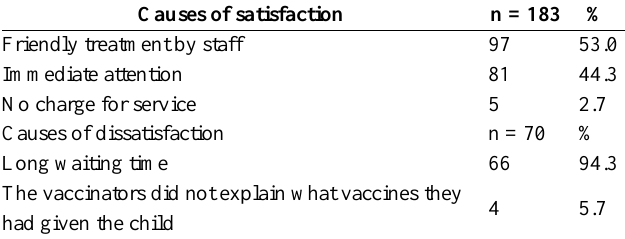
Causes of being satisfied or dissatisfied with the immunization services.